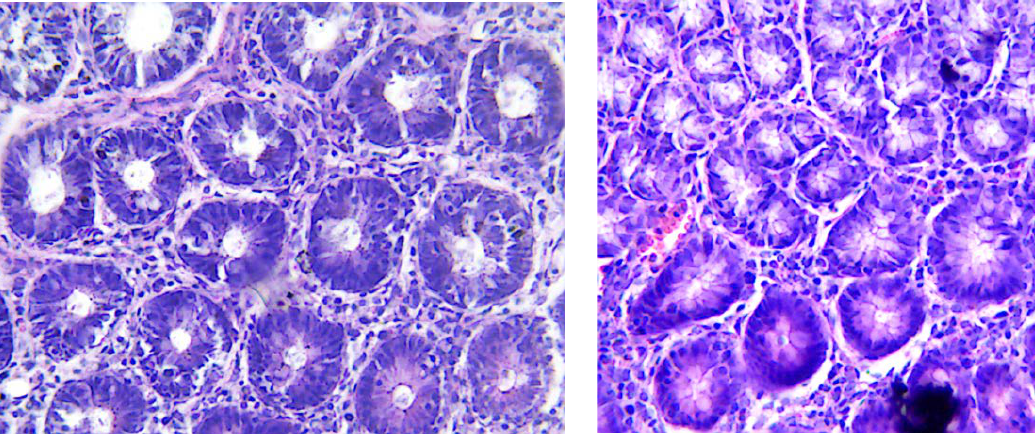
Fi gur e 2e : M ed i um dose groups.